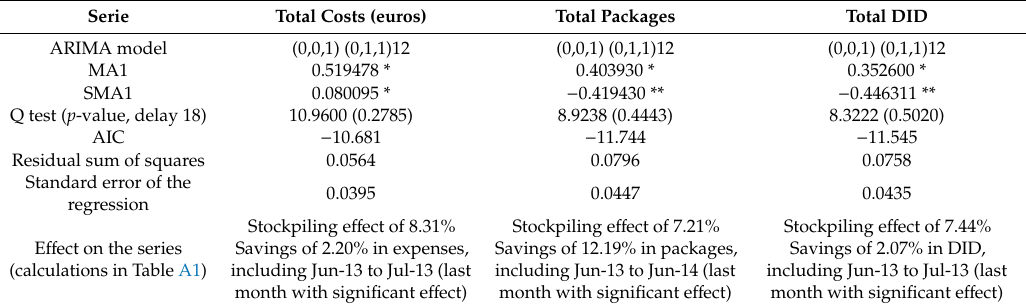
Table 1. Royal Decree-Law (RDL) no. 16 / 2012, counterfactual analysis of the series of costs ( € ), packages, and DID. Real values from January 2009 to May 2013 and predictions from June 2013 to June 2014. Serie Total Costs (euros) Total Packages Total DID ARIMA model (0,0,1) (0,1,1)12